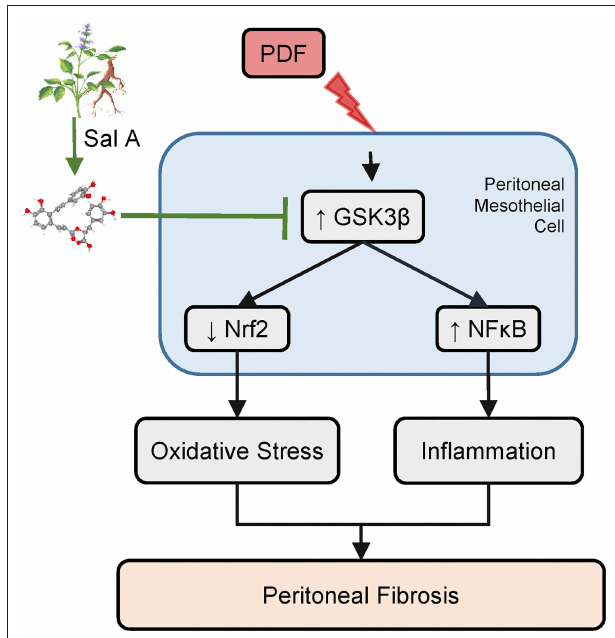
FIGURE 7 | A schematic diagram depicts the molecular mechanism underlying the protective effect of Sal A, the active ingredient of Salvia miltiorrhiza , on peritoneal fibrosis, inflammation, and oxidative injury in murine models of peritoneal dialysis. As a key active component of Salvia miltiorrhiza , Sal A is able to directly bind to and inhibit GSK3 β (14). GSK3 β is a convergent point of myriad pathways modifying the severity of peritoneal fibrosis, including the NF κ B directed inflammatory response pathway and the Nrf2 antioxidant pathway. Inhibition of GSK3 β by Sal A mitigates NF κ B phosphorylation and activation and reinforces Nrf2 antioxidant self-defense in peritoneal mesothelial cells and thereby attenuates inflammation, maladaptive angiogenesis and oxidative damage in peritoneum exposed to the hypertonic PDF, resulting in an improved peritoneal